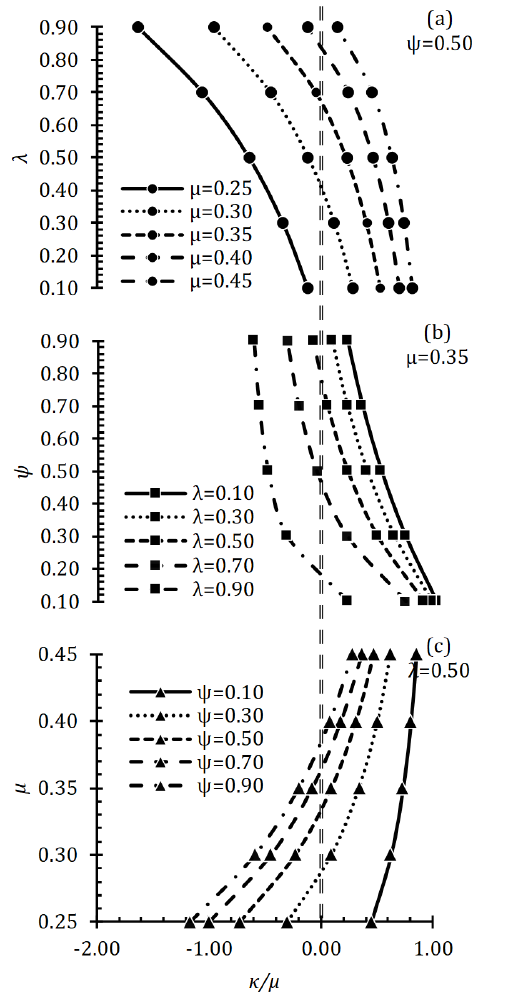
Figure 6. Effect of λ , ψ and µ on κ . Figure 7. Effect of λ , ψ and µ on v max .